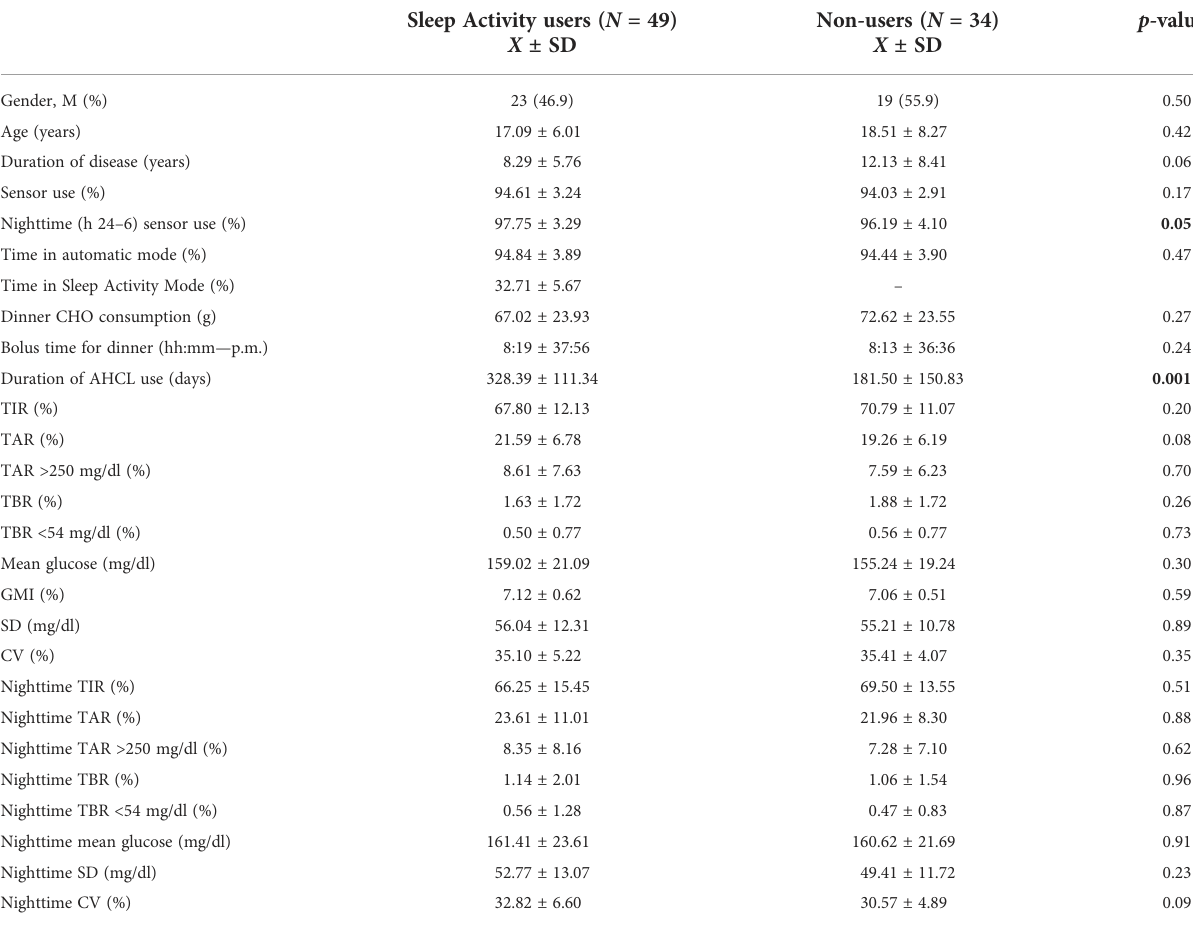
TABLE 1 Comparison of the overall and nighttime (h 24 – 6) glycemic control of Sleep Activity Mode users (group 1) and non-users (group 2); analysis included patients using sensor and automatic mode ≥ 80% ( N =